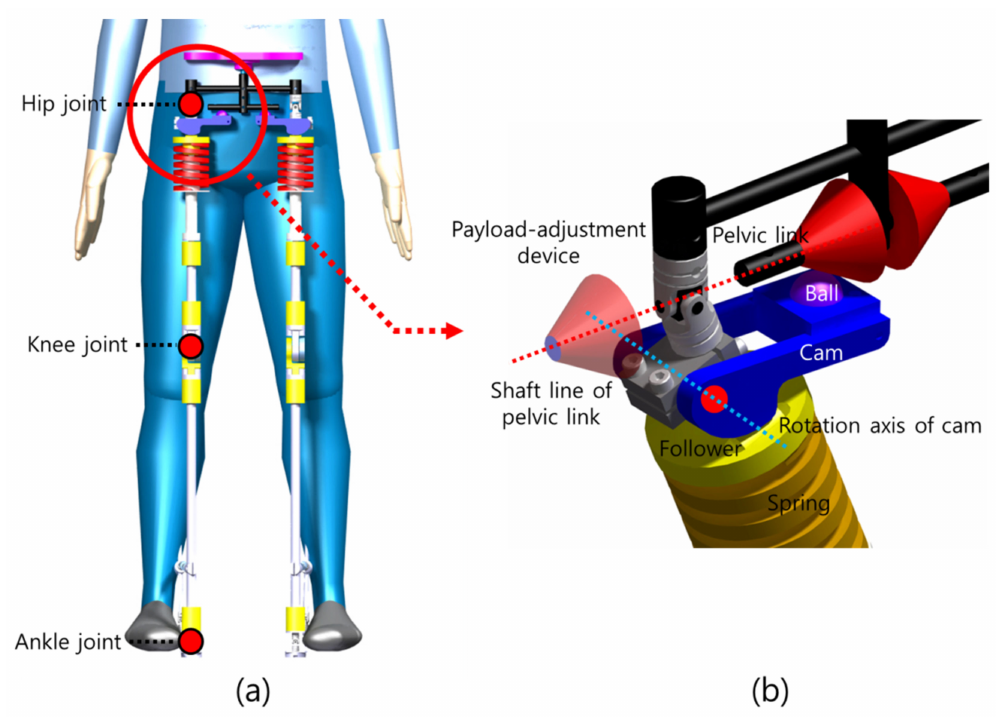
Figure 1. Schematic of the exoskeleton: ( a ) previous model; ( b ) new model with a payload adjustment device. In Figure 1b, the exoskeleton consists of a black pelvic link, blue cam, yellow